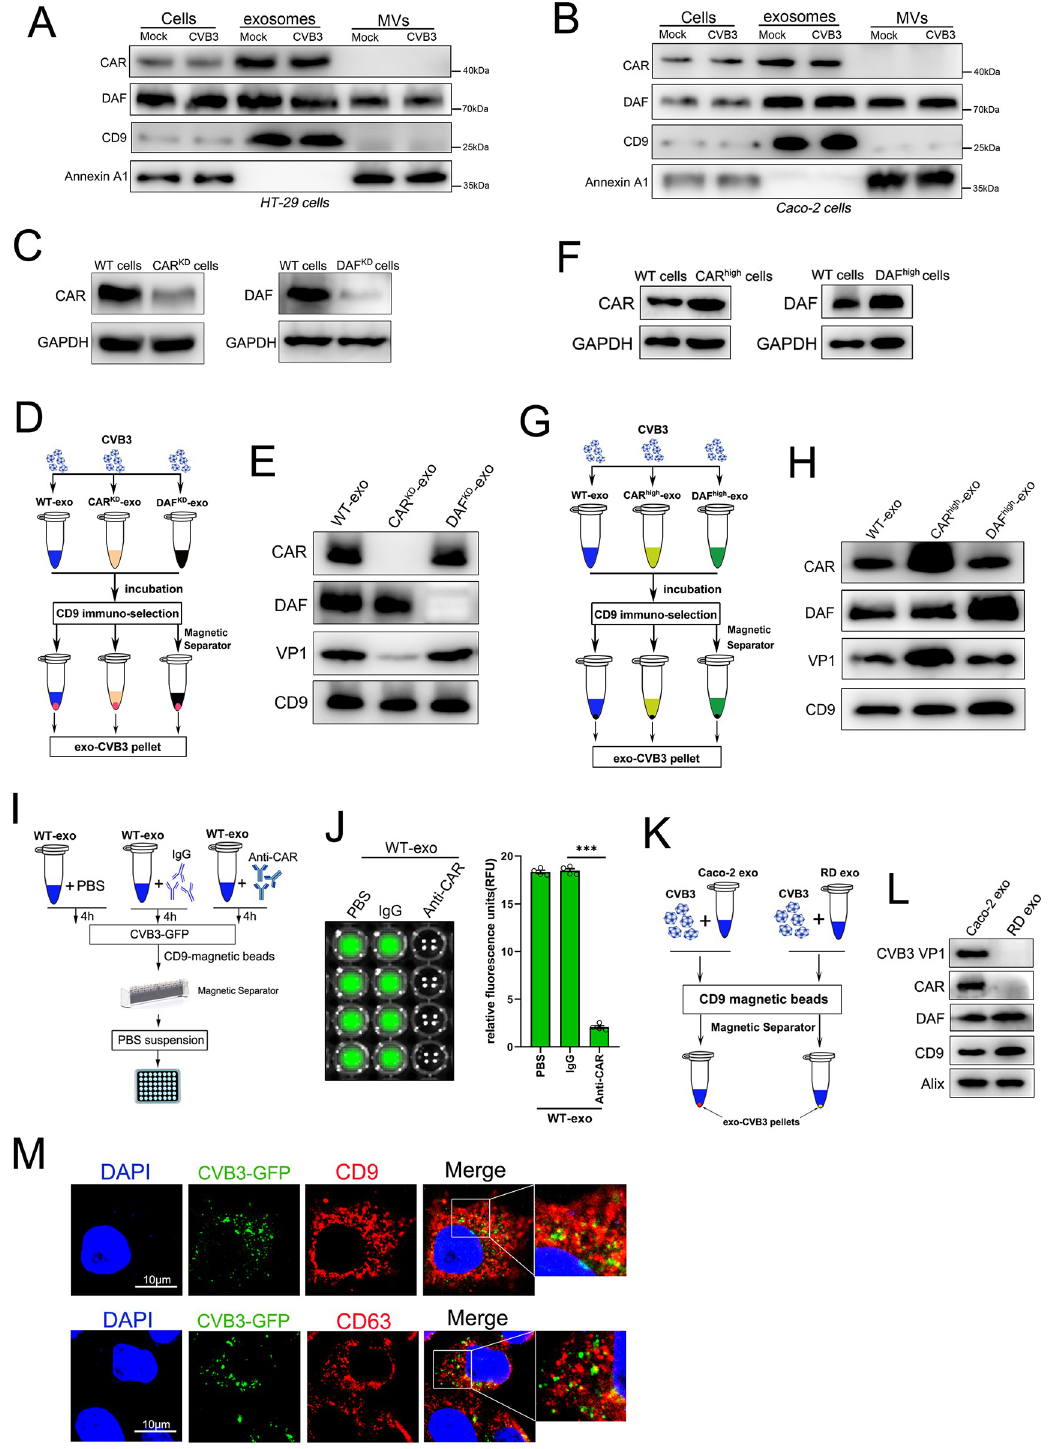
Fig 5. Exosome coupling with CVB3 virions depended on CAR but not DAF. (A and B) The exosomes and MVs derived from CVB3-infected cells or mock cells were analyzed by western blot with antibodies of viral receptors(CAR and DAF), exosomal markers(CD9) and MVs markers(Annexin A1). EVs were collected from equivalent amounts of culture medium, conditioned by equal numbers of cells, for equal lengths of time. The whole cell lysates as positive control. (C) Western blot analysis of CAR and DAF in stable knockdown Caco-2 cells(CAR KD cells and DAF KD cells). (D and E) Purified exosomes derived from WT cells,